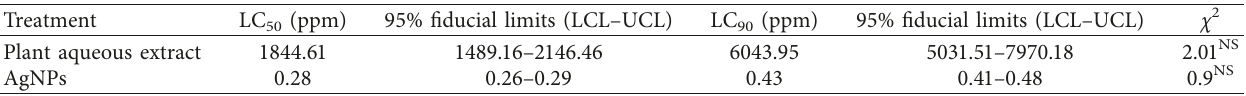
Table 2: Probit values of plant aqueous extracts and silver nanoparticles synthesized using leaves of Ambrosia arborescens against Aedes aegypti third instar